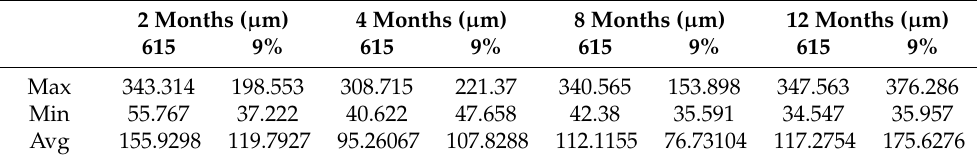
Table 4. Summary of pit depth measurements on cross-sections of both ASTM615 and 9% Cr steel rebar.